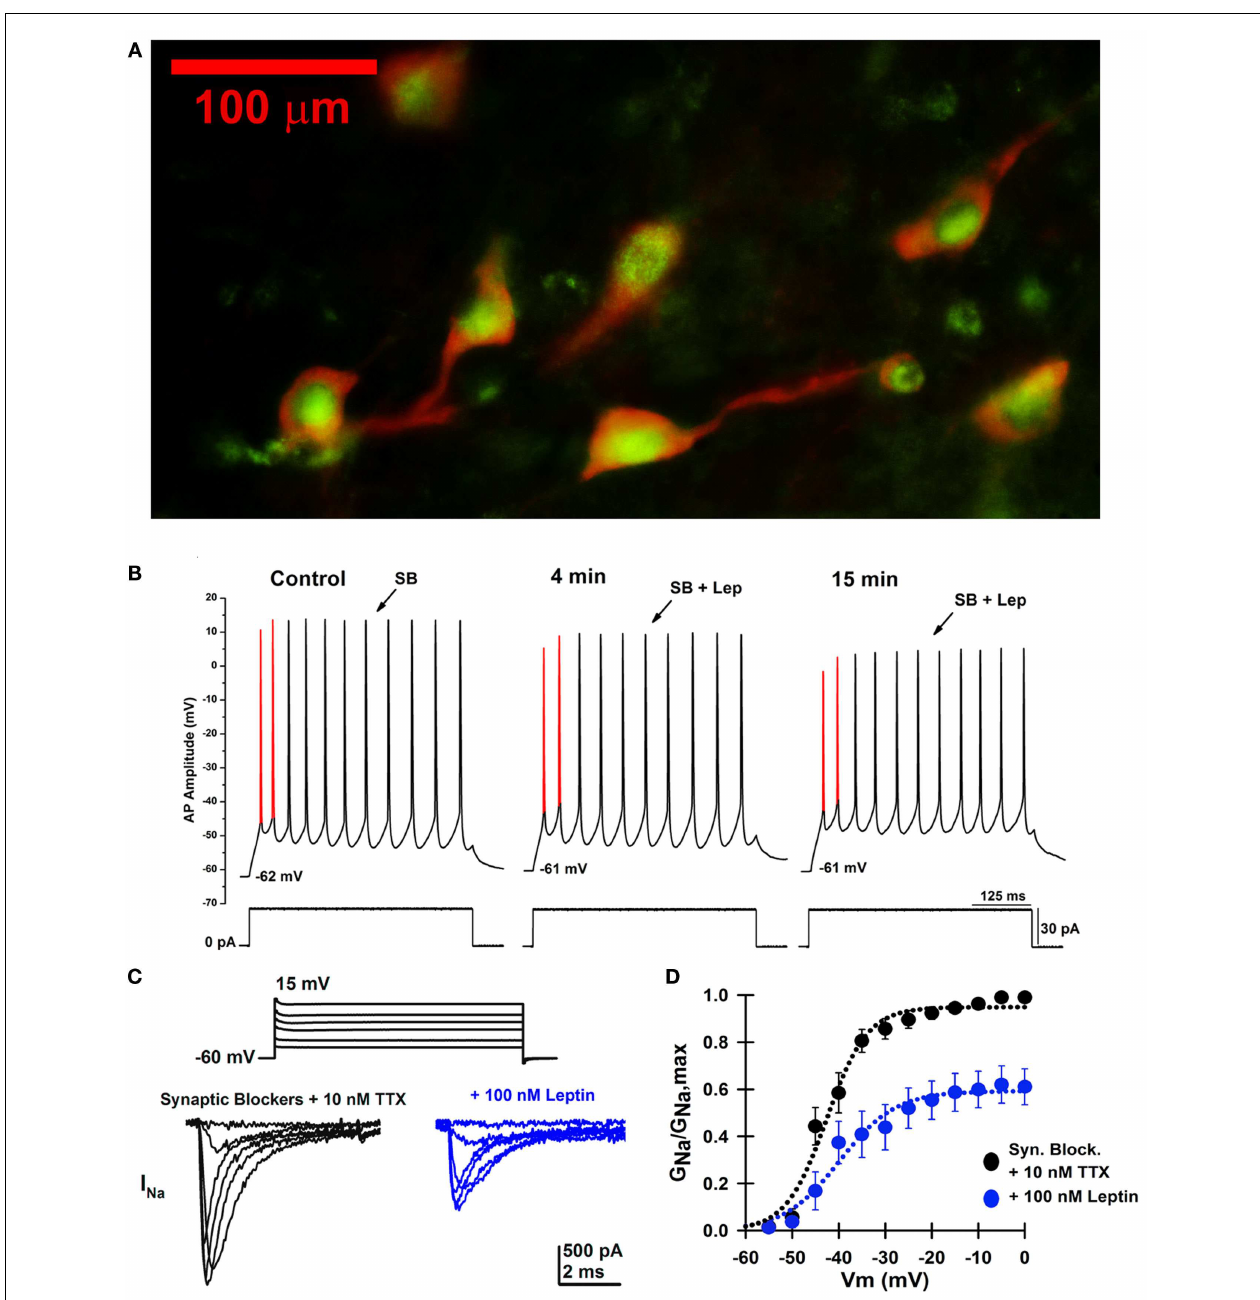
highlighted in red from AP threshold to AP peak amplitude. Note the gradual decrease in AP amplitude during the time course, suggesting that leptin reduced sodium currents. (C) Whole-cell patch clamp recording in the same PPN neuron in the presence of SB, 0.2mM CdCl 2 , 0.2mM NiCl 2 , 20mMTEA-Cl, and 3–10nMTTX before (black records) and after 15min of leptin exposure (100nM, blue records).The neuron was subjected to voltage steps from − 60 to + 15mV. (D) Average sodium conductance as a fraction of maximum conductance before (black curve) and after 15min of leptin exposure (blue curve).These results suggest that leptin partially reduced sodium currents in PPN neurons, which decreases the activation of waking and REM sleep by the PPN (88,